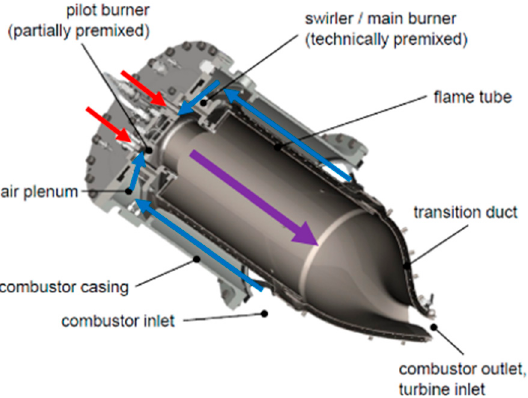
Figure 1. 3D cross-sectional view of the can combustor assembly of the MGT ACC system. Main parts, as well as important positions, are named in the figure. Blue arrows indicate compressor airflow, red arrows show gaseous fuel flow, and the purple arrow indicates exhaust air after combustion. Fuel-gas and liquid-fuel flames are usually stabilized in the region of the area jump between swirler and flame tube.